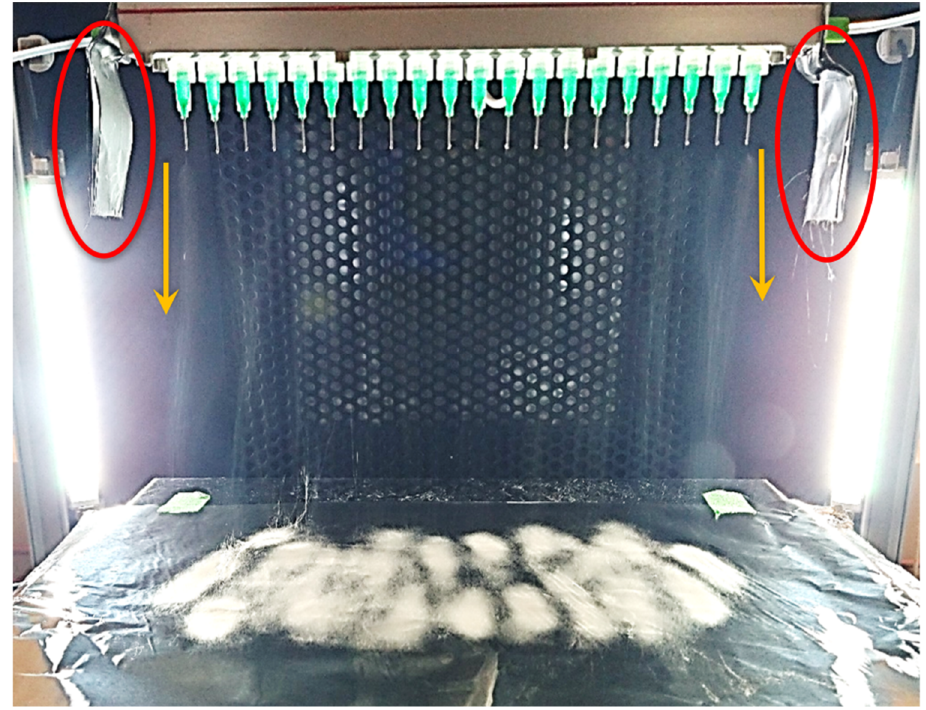
Figure 5. Multi-needle electrospinning with parallel plate auxiliary electrodes (indicated in red).